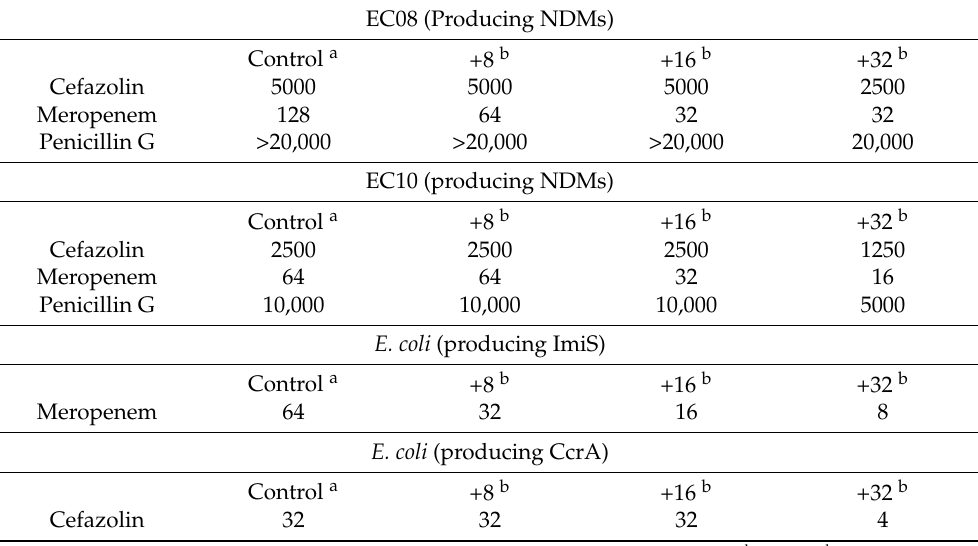
Table 3. Antibacterial activities (MICs, µ g/mL) of vancomycin derivative V b synergizing with β - lactam antibiotics against resistant E. coli producing M β Ls (NDMs, ImiS and CcrA) at a dose of 8, 16, and 32 µ